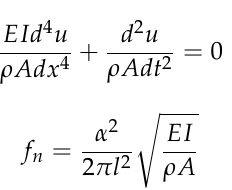
Figure 3. Time domain of the free impact test.